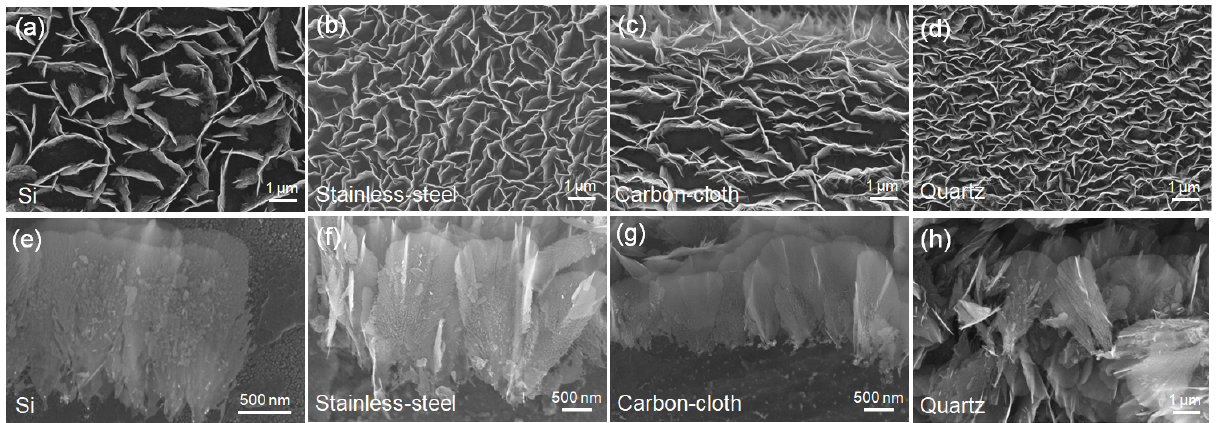
Figure 1. Top-view and side-view of the morphology of VFLG on different substrates. ( a ) and ( e ): Si substrate; ( b ) and ( f ): stainless-steel substrate; ( c ) and ( g ): flexible carbon-cloth substrate; ( d ) and ( h ): quartz substrate.